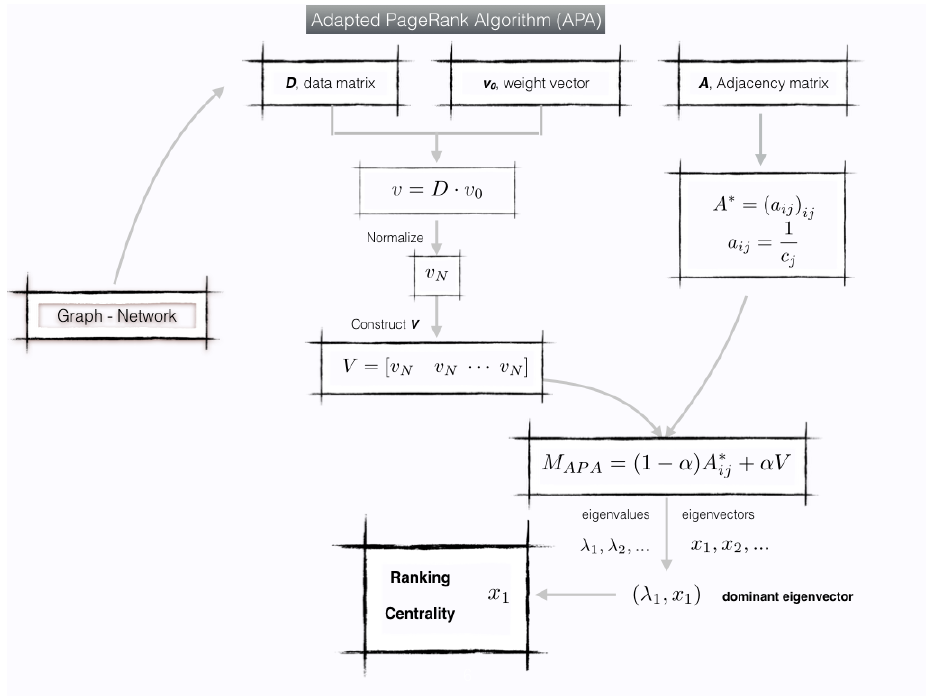
Figure 1. Scheme of the APA